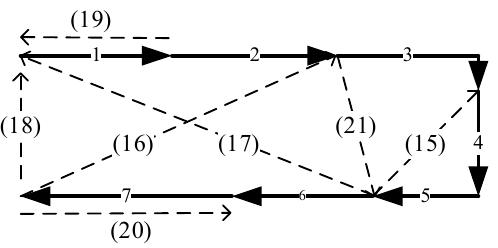
Figure 3. Examples for Equations (15)–(21).